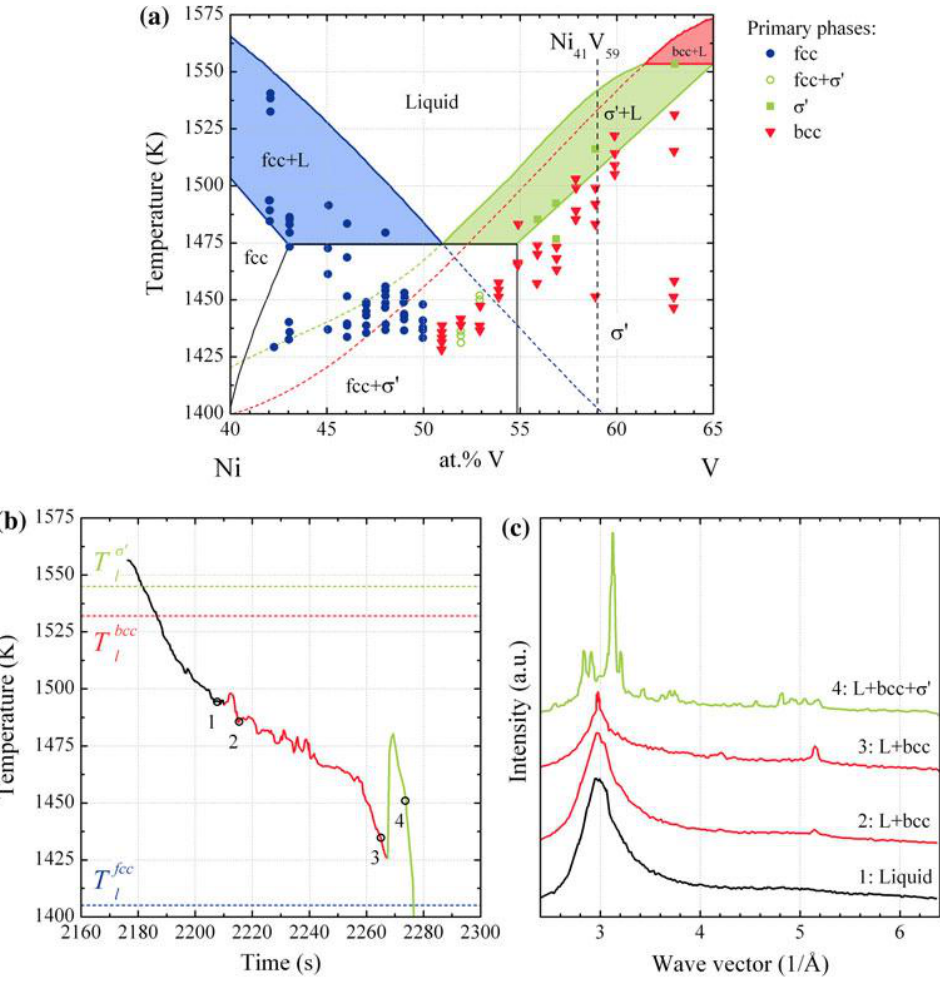
Figure 4. ( a ) nucleation map of Ni-V system after [10]. The symbols mark the primarily solidified phases as a function of composition and nucleation temperature. Metastable extensions of the equilibrium liquidus lines are shown by dotted lines. ( b ) Temperature–time profile and ( c ) corresponding X-ray diffraction patterns recorded during solidification of a levitated Ni V alloy. Numbers 1–4 mark the time at which the patterns are recorded. 41 59 Related liquidus temperatures of the stable ζ’ and the metastable bcc and stable fcc phases are shown. A part of the undercooled melt (pattern 1) primarily crystallizes into the metastable bcc phase (pattern 2 and 3) followed up by the crystallization of the intermetallic ζ’ phase (pattern 4), taken from